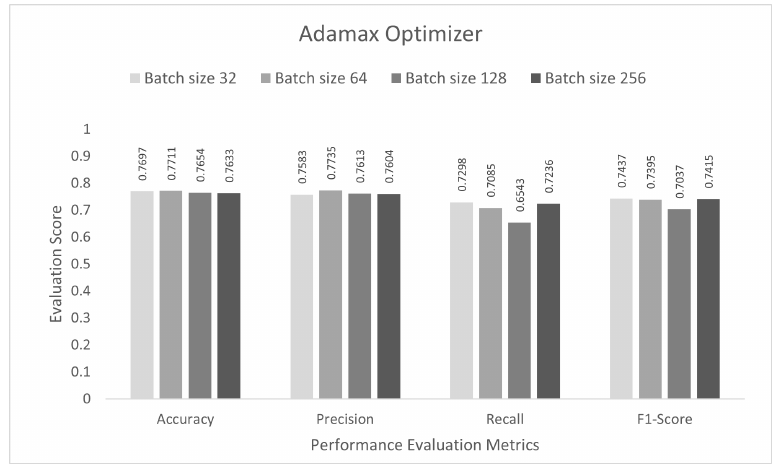
Figure 11. AdaMax optimizer for multi-class sub-category classification